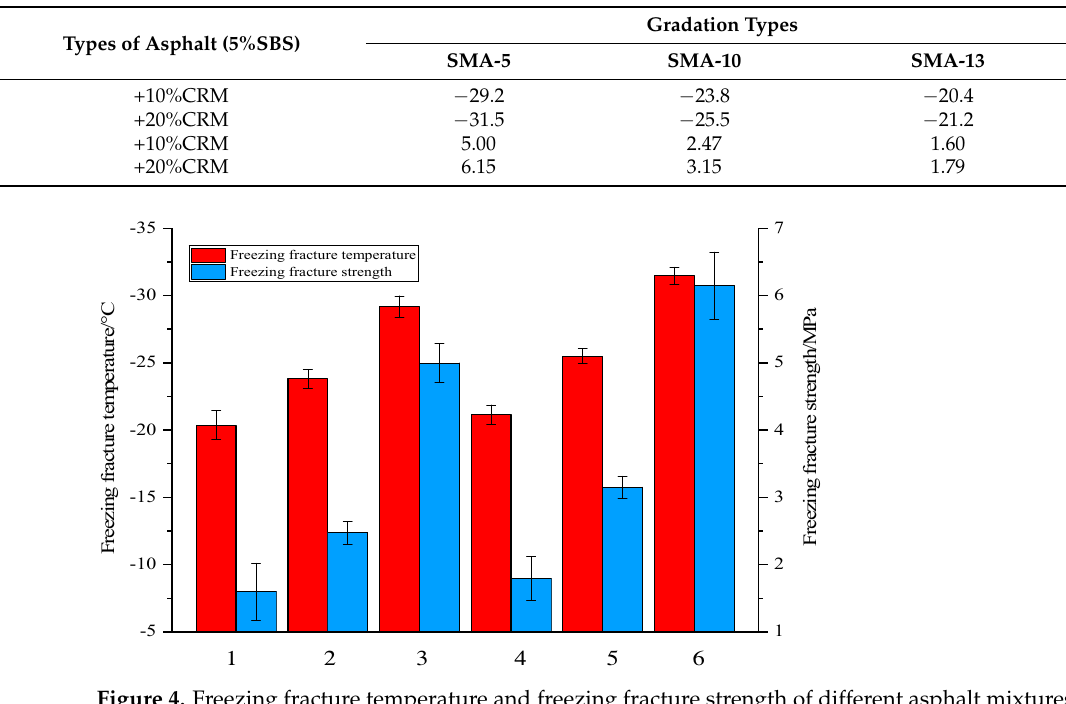
Figure 4. Freezing fracture temperature and freezing fracture strength of different asphalt mixtures.